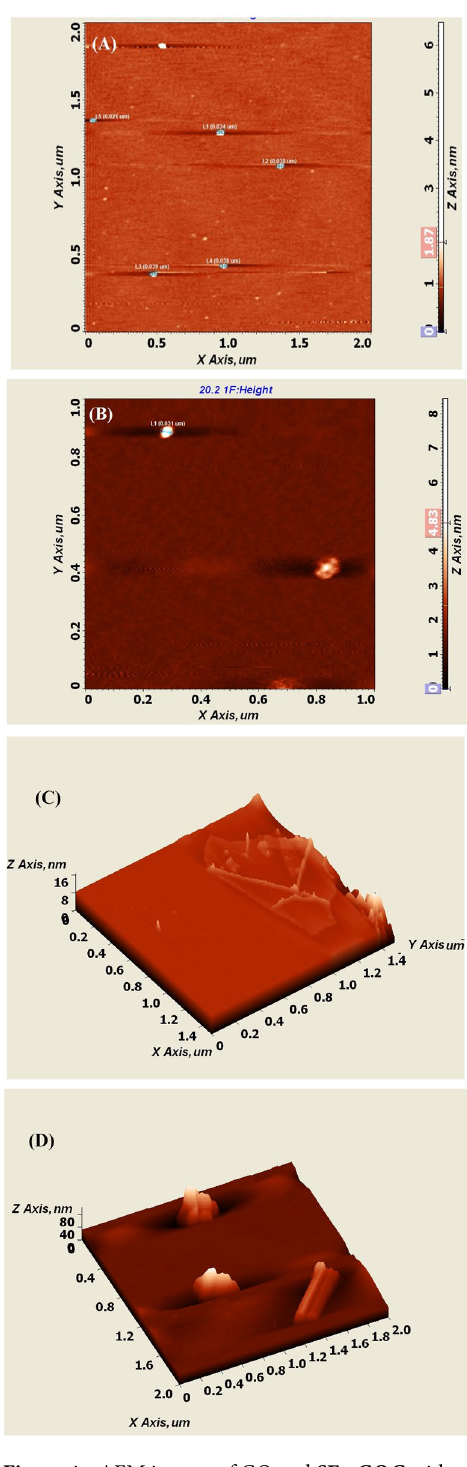
Figure 4. AFM images of GO and SF@GOC with particle size ( A , B ); images with corresponding 3 D views (GO: C and SF@GOC : D